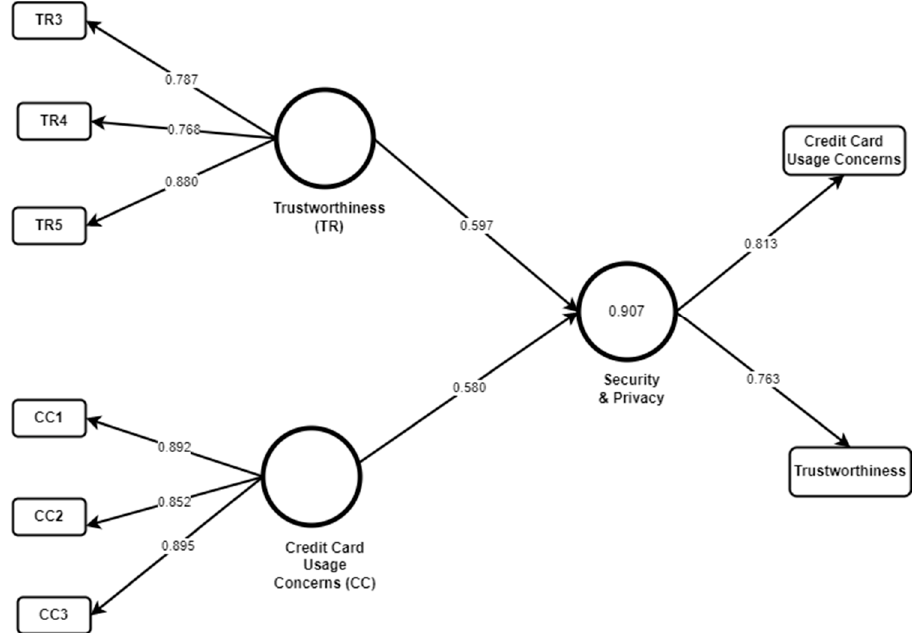
Figure 3. CenterPoint model.